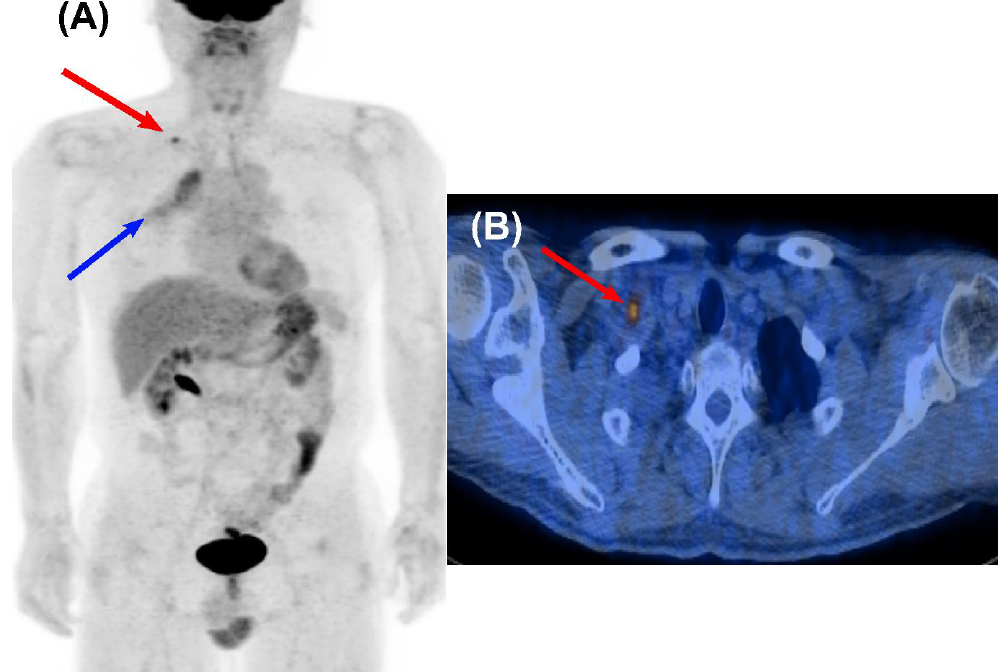
Figure 1. Loco-regional recurrence detected by surveillance FDG PET/CT in a 54-year-old male who underwent curative surgery for NSCLC. Focal FDG uptake was noted in the right supraclavicular lymph node on a maximum intensity projection (MIP) ( A ) and a transaxial fused PET/CT image ( B ) obtained at 7 months after curative resection. The lesion was confirmed as biopsy-proven recurrence (red arrow). He survived for 60 months after localized treatment for the lesion. Diffusely increased FDG uptake on the right upper lung field indicates radiation pneumonitis (blue